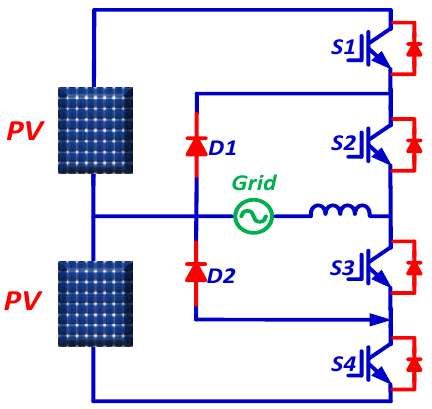
Figure 4. Three-level half-bridge diode clamped inverter [36].